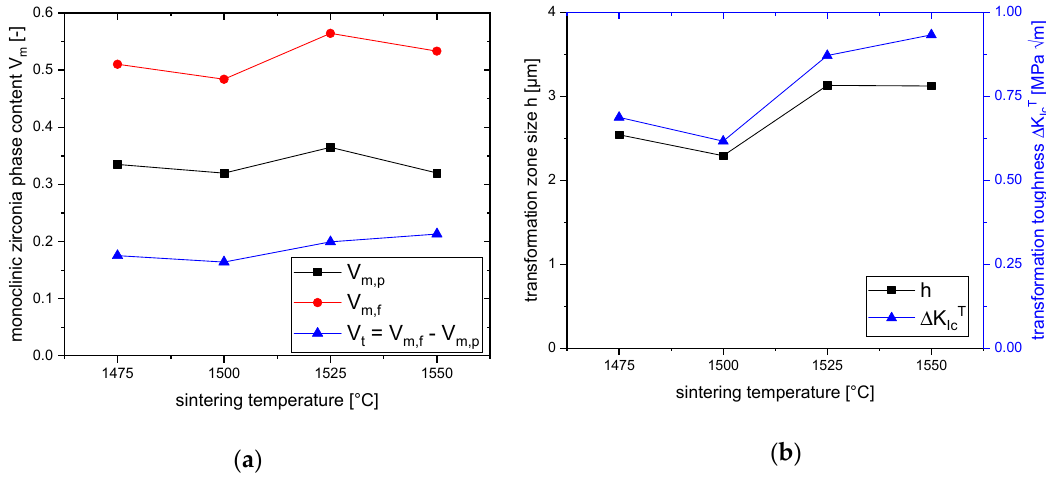
Figure 4. ( a ) monoclinic zirconia phase contents in polished surfaces V m,p , in fracture surfaces V m,f and transformability V f , ( b ) transformation zone size h and transformation toughness increment Δ KICT.